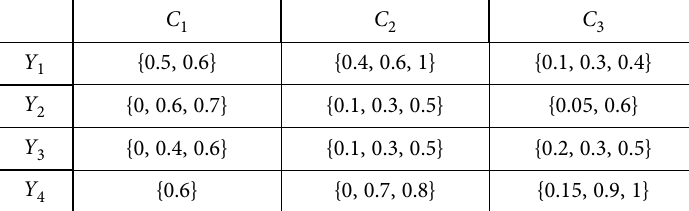
Table 2. Hesitant fuzzy decision matrix D ( t 1